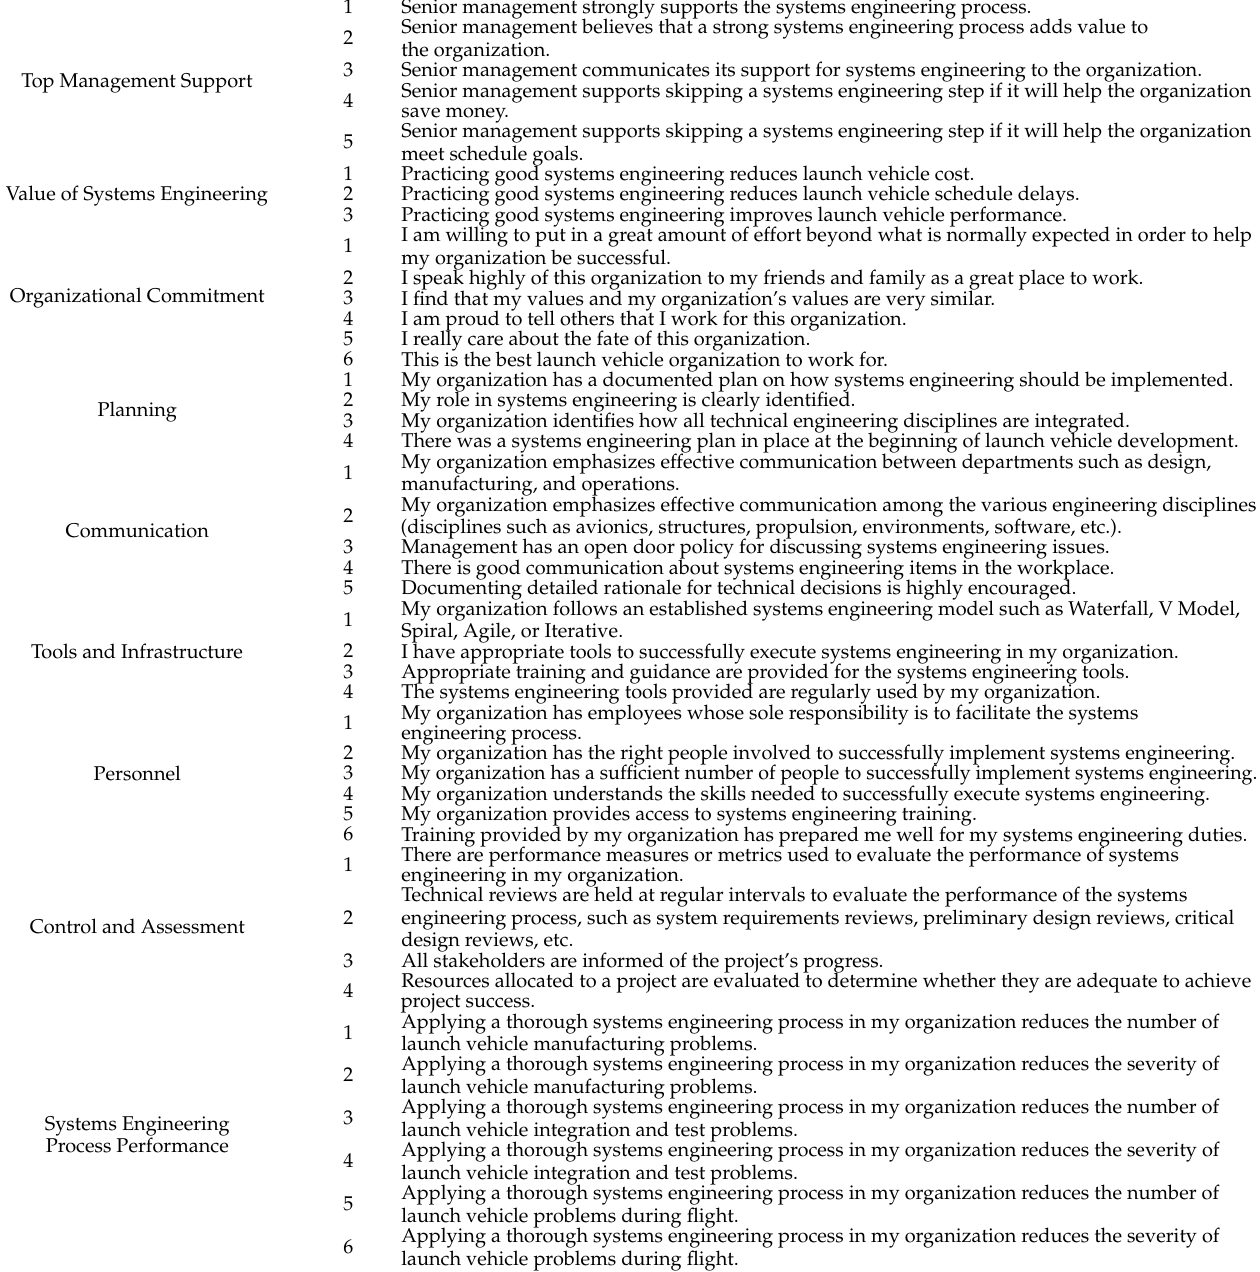
Table 2. Study Dimensions and Survey